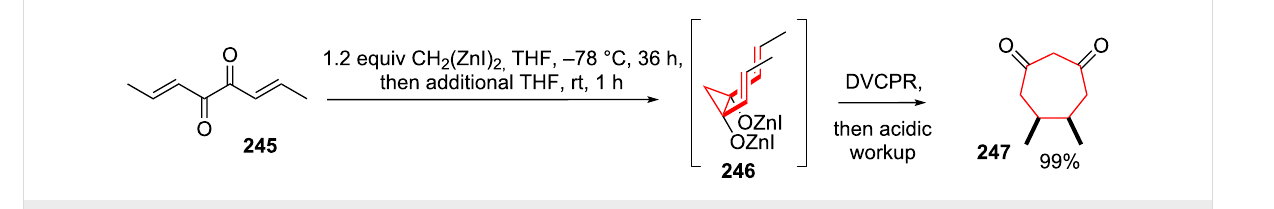
Scheme 31: Matsubara’s version of a